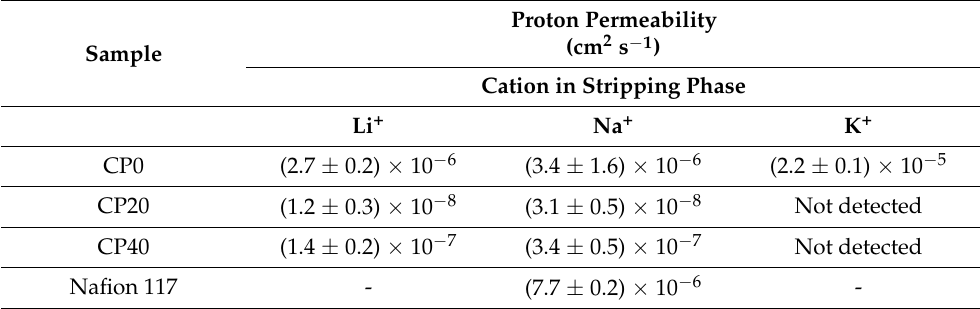
Table 4. Proton permeabilities of CP0, CP20, and CP40 in the presence of different cations in the stripping